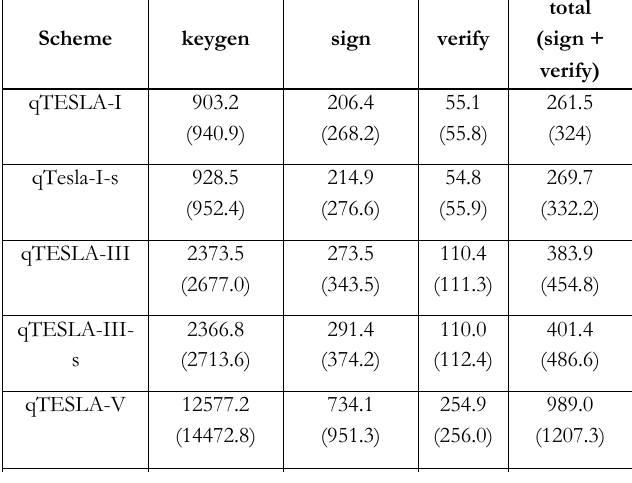
Table 6. Second Round AVX2